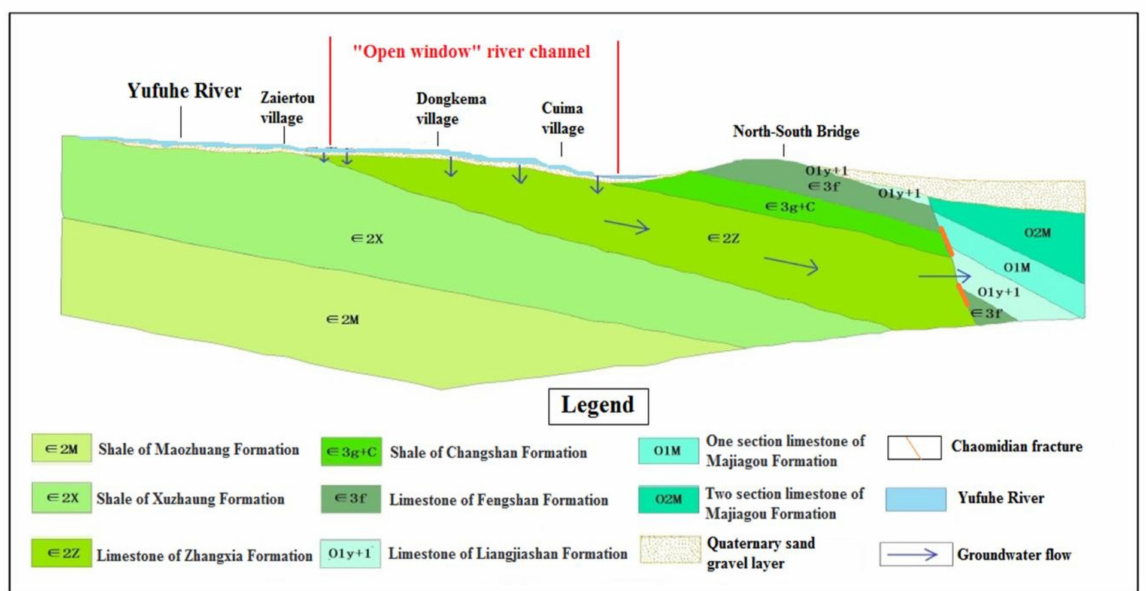
Figure 2. Geological profile of the study